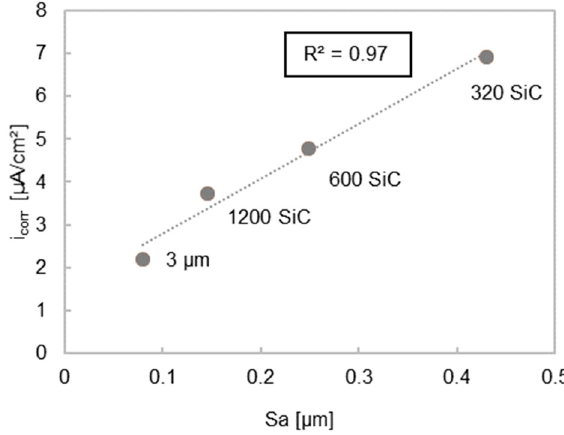
Figure 1. Graph shows a linear relationship between Sa and i corr after grinding and polishing. R² is the coefficient of determination, which assess the linear mutual dependence of x and y. R² = 1 defines the highest linearity [97]. Sa and i corr values were obtained from [96].